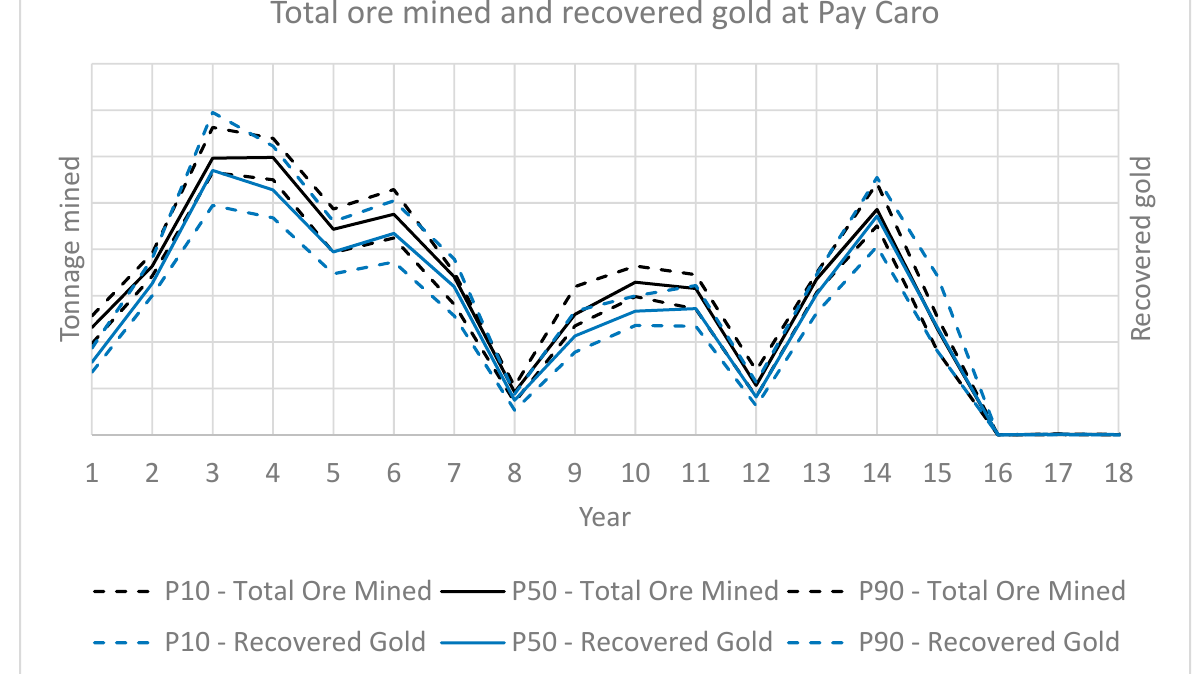
Figure 7. Ore tonnage mined and recovered gold at the Pay Caro Mine.